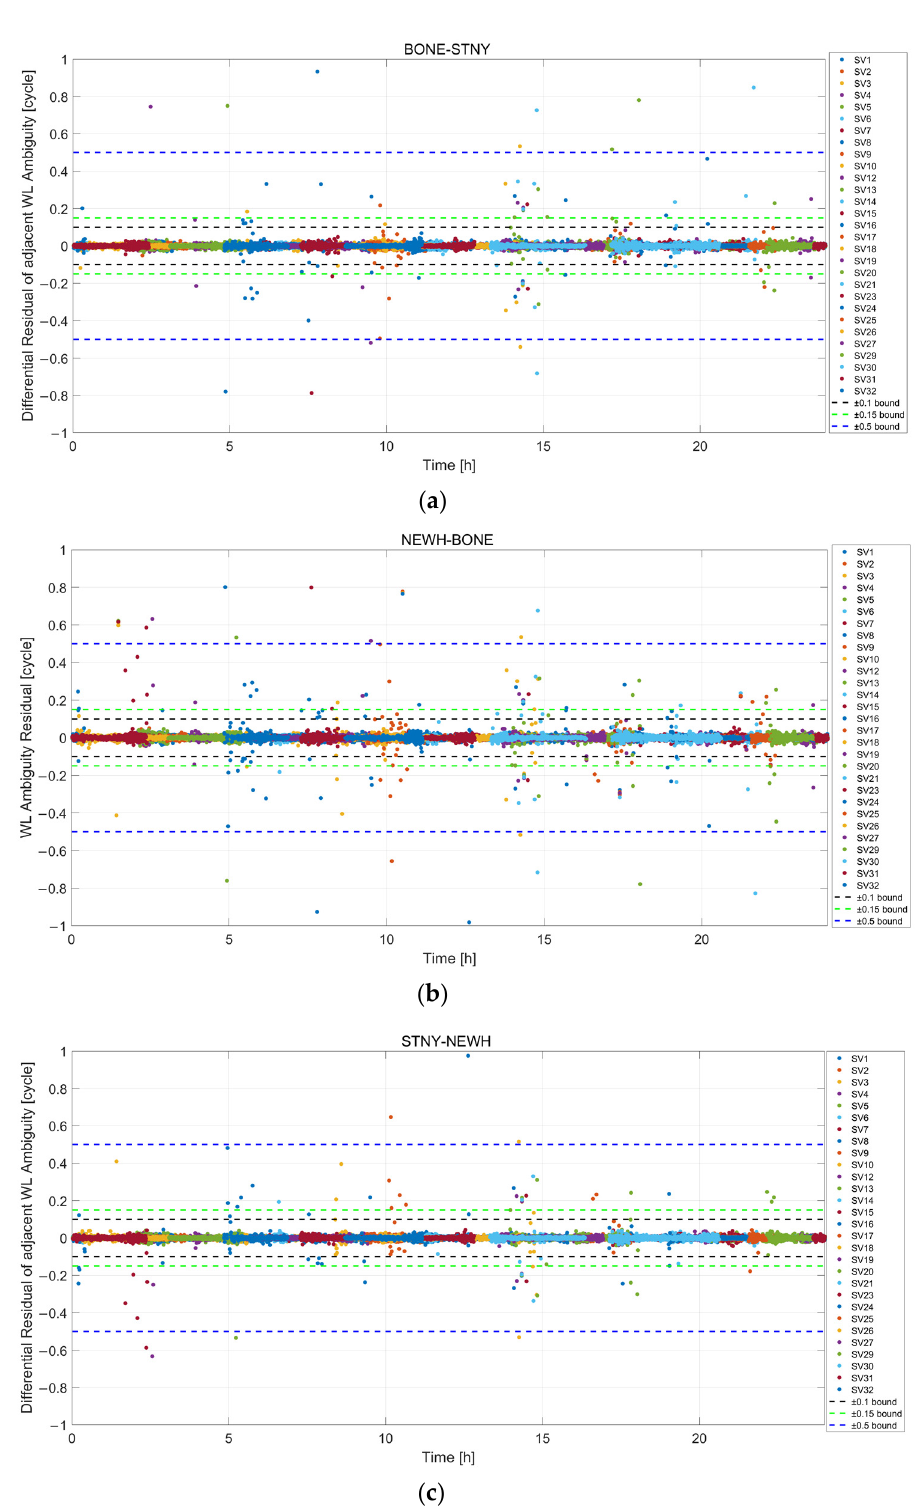
Figure 9. The ∇ ∆ N w for each baseline of the triangle closure network. ( a ) BONE-STNY; ( b ) NEWH- BONE; ( c ) STNY-NEWH. Table 3. ∇ ∆ N w statistics of the triangle closure network.